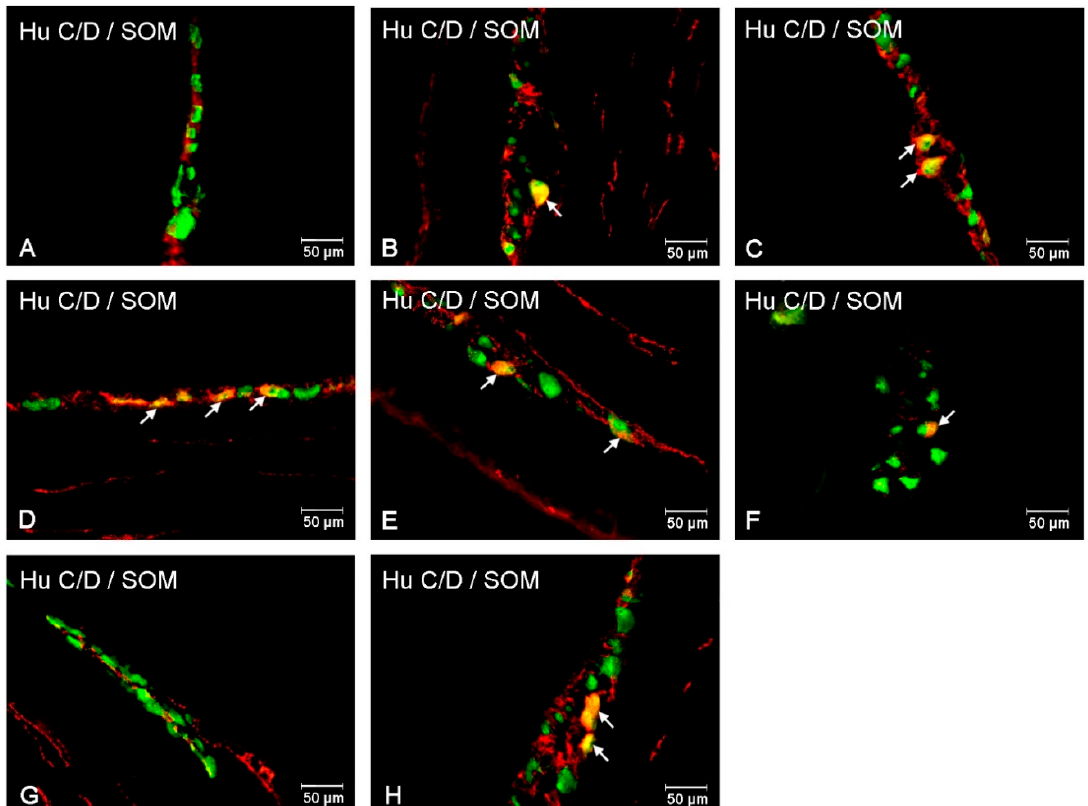
Figure 3. Intramural plexuses in the porcine stomach (antrum, stomach, and pylorus) immunoreactive to SOM. Myenteric plexus of the antrum ( A ), corpus ( B ), and pylorus ( C ) under physiological condition ( A – C ), and after streptozotocin administration ( D – F ). Submucosal plexus of the corpus ( G ), under physiological state and after streptozotocin injection ( H ). All photographs have been created by digital superimposition of two color channels (green for Hu C / D used here as a pan-neuronal marker, and red for SOM). Neurons showing co-localization of Hu C / D and SOM are indicated with arrows.